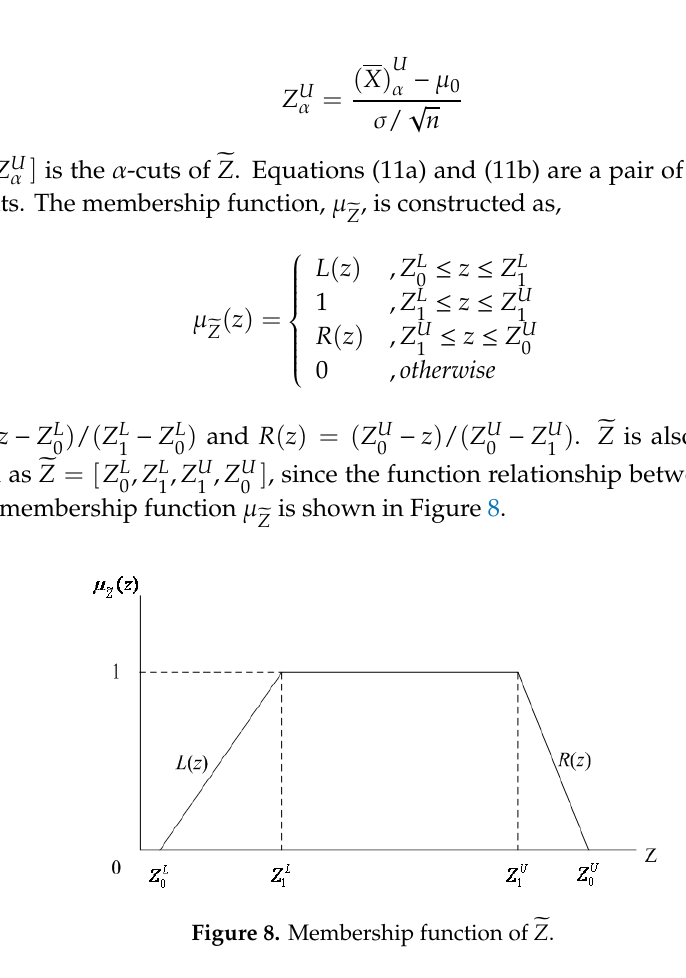
Figure 8. Membership function of (cid:101) Z .